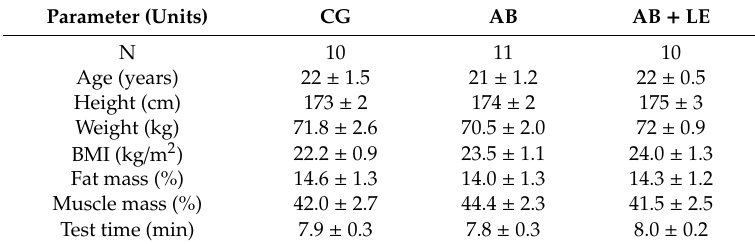
Table 2. Age, anthropometric parameters (determined at the moment of recruitment) and results of the 2000-m test in control (CG), almond beverage (AB) and almond beverage + Lippia extract (AB + LE) groups.